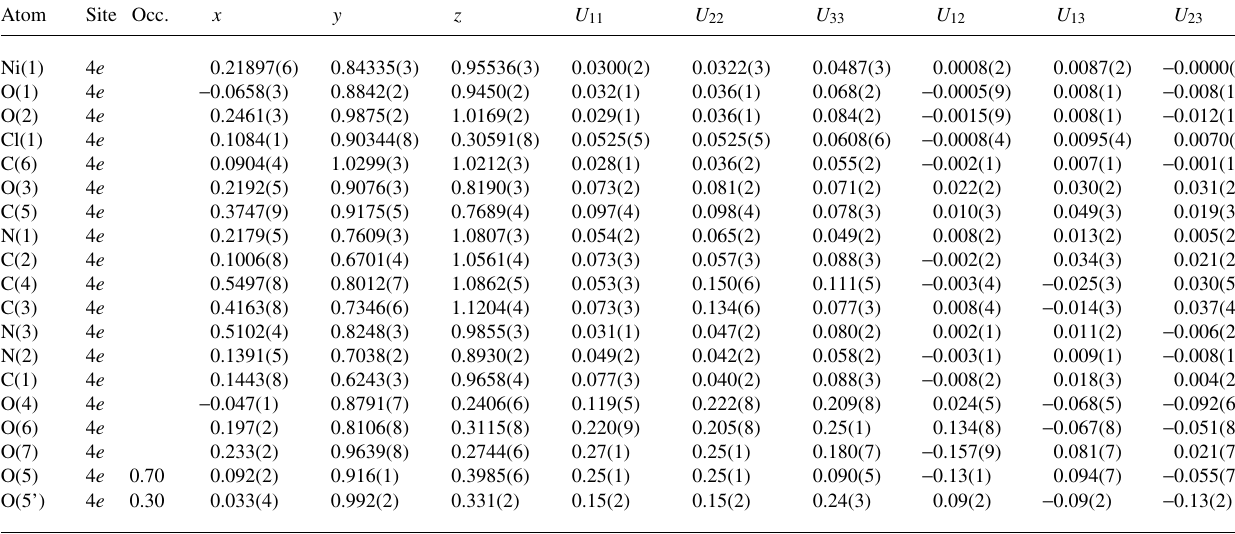
Table 3. Atomic coordinates and displacement parameters (in Å 2 ) .